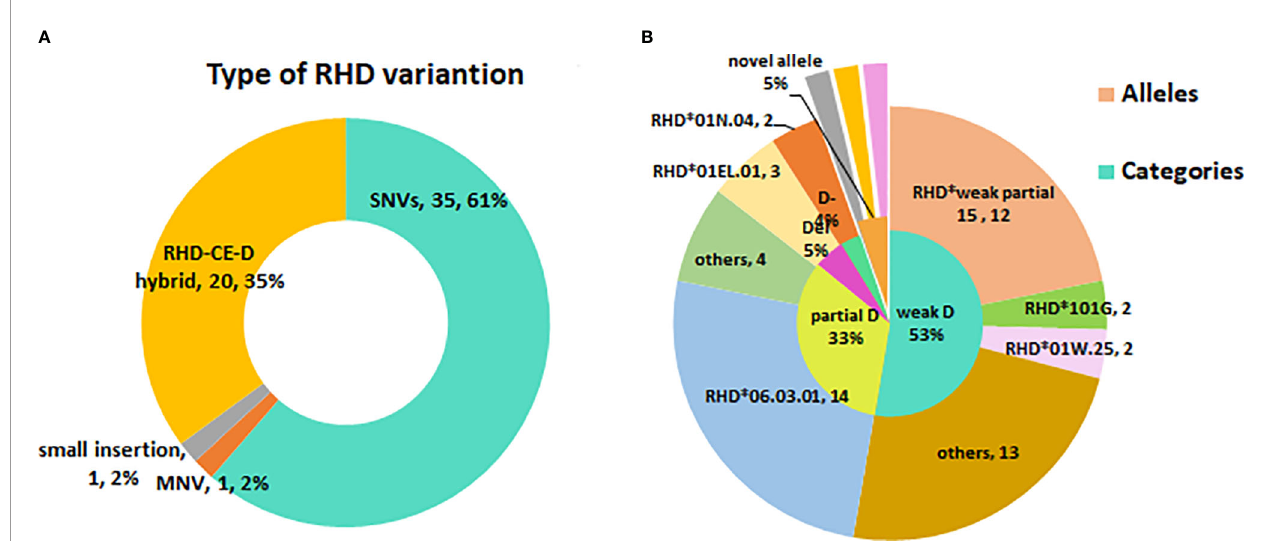
FIGURE 1 | The pro fi le of RHD variant allele ’ s diversity in eastern Chinese RhD variants. (A) Type of RHD variation. (B) The inner small circle is the allele categories map. The outer big circle is the speci fi c allele